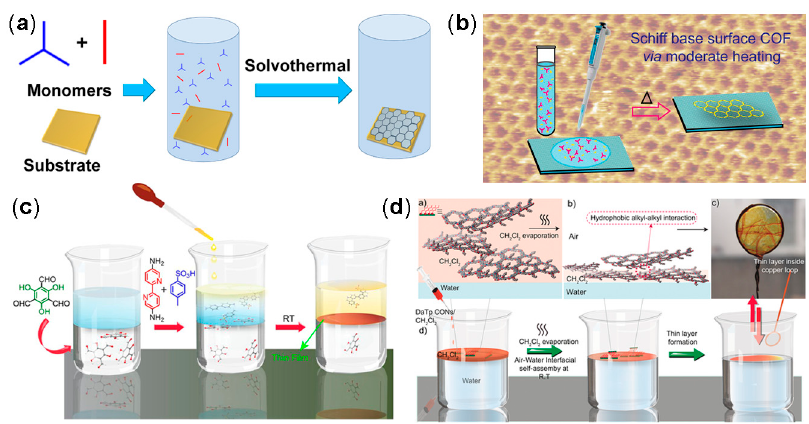
Figure 5. Schematic representations of COFs synthesis at the interface between ( a ) solid-liquid; ( b ) solid-vapor, reproduced with permission from [177]. Copyright American Chemical Society, 2013; ( c ) liquid-liquid, reproduced with permission from [178]. Copyright American Chemical Society,